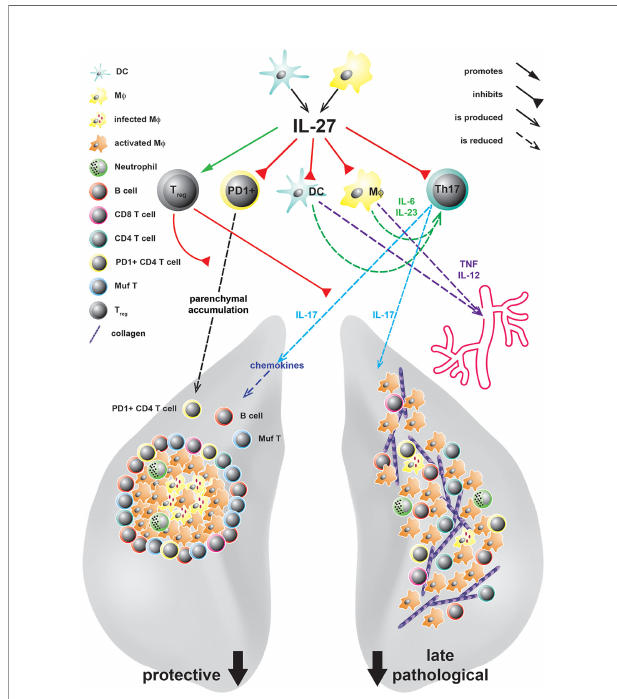
FIGURE 2 | IL-27 in experimental TB and its protective and pathological immune responses at different states of Mtb infection. IL-27, produced by DC or M F in response to infection with Mtb, acts on various cell types. It controls the accumulation of PD1 + CD4 T cells in the lung parenchyma and limits the expansion of IL-17A-producing Th17 cells either directly or indirectly by increasing the numbers of T reg or inhibiting the production of the Th17-driving cytokines IL-6 and IL-23 by DC and M f . Thereby, defending mechanisms as in fi ltration of the lung tissue with PD + CD4 + T cells, the chemokine-mediated formation of protective granulomas, the recruitment of B cells and IFN g /TNF/IL- 2-producing multifunctional (Muf) T cells as well as subsequent M F activation are diminished by IL-27. However, even if IL-27 suppresses these protective functions, during later states of infection it also controls lung-speci fi c advanced in fl ammatory cell in fi ltration and interstitial collagen deposition but additionally systemic cytokine levels and eventually premature